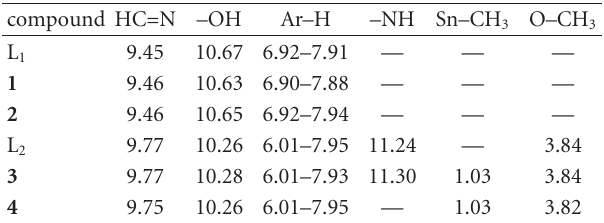
Table 3: 1 H-NMR data of the ligands and organotin(IV) com-